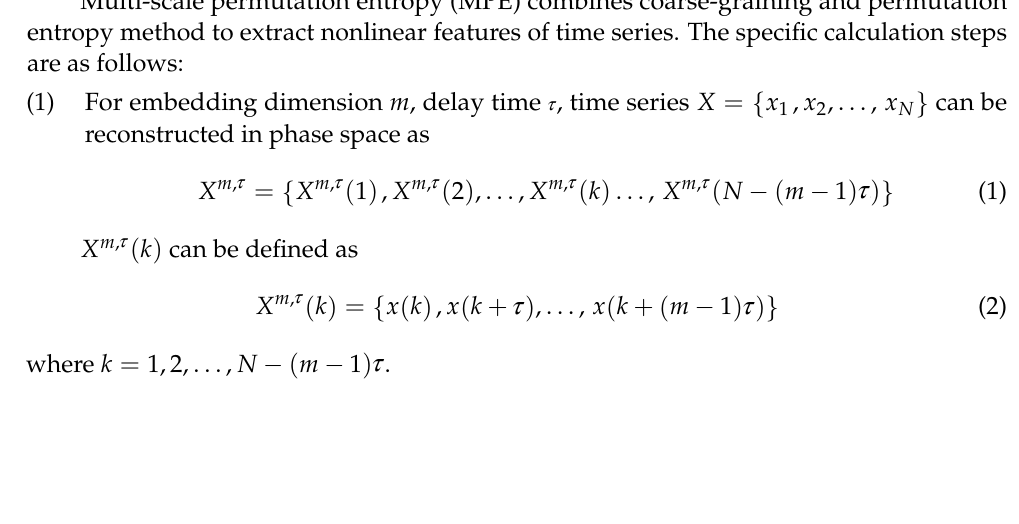
Figure 1. The traditional coarse-grained process with the scale